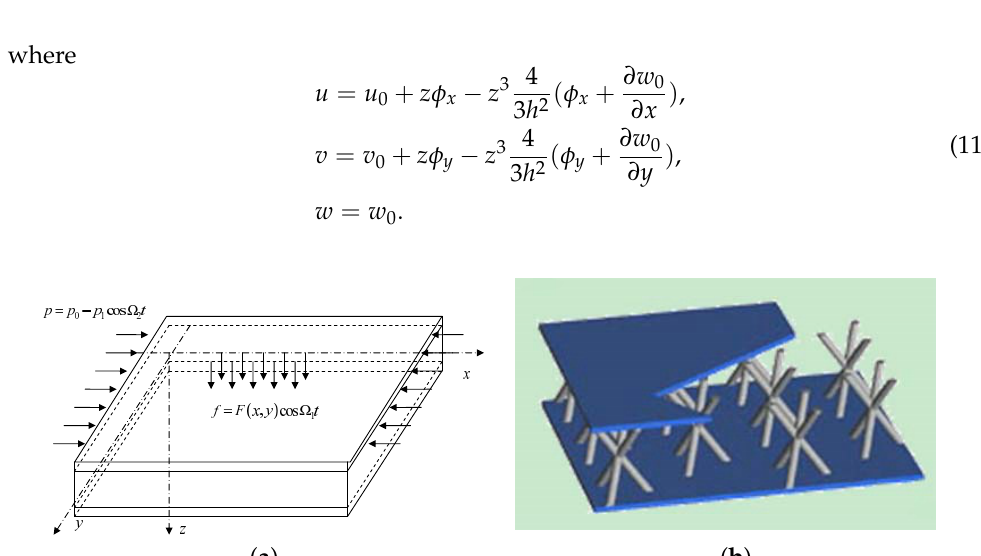
Figure 1. The model of the sandwich plate with truss core: ( a ) schematic with the coordinate system; ( b ) the 3D-Kagome truss core sandwich